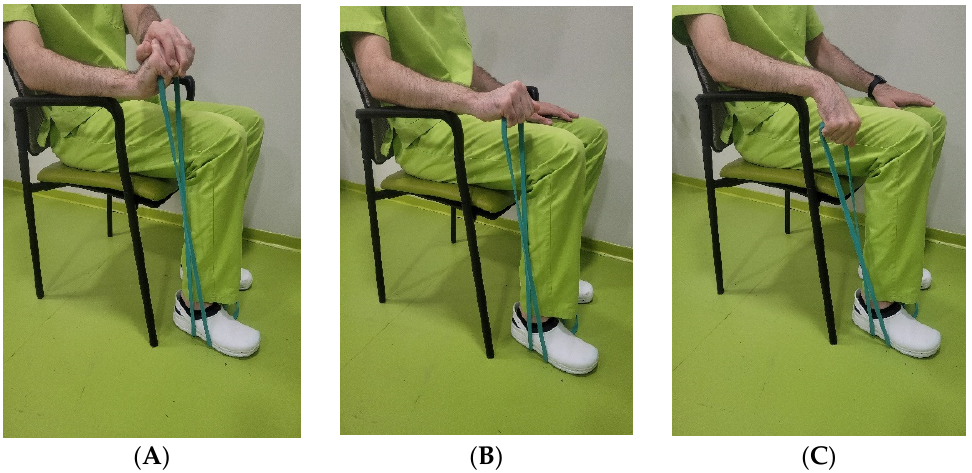
Figure 3. Patient in the control group performing the exercise using the elastic band: ( A ) starting position; ( B ) intermediate position; ( C ) final